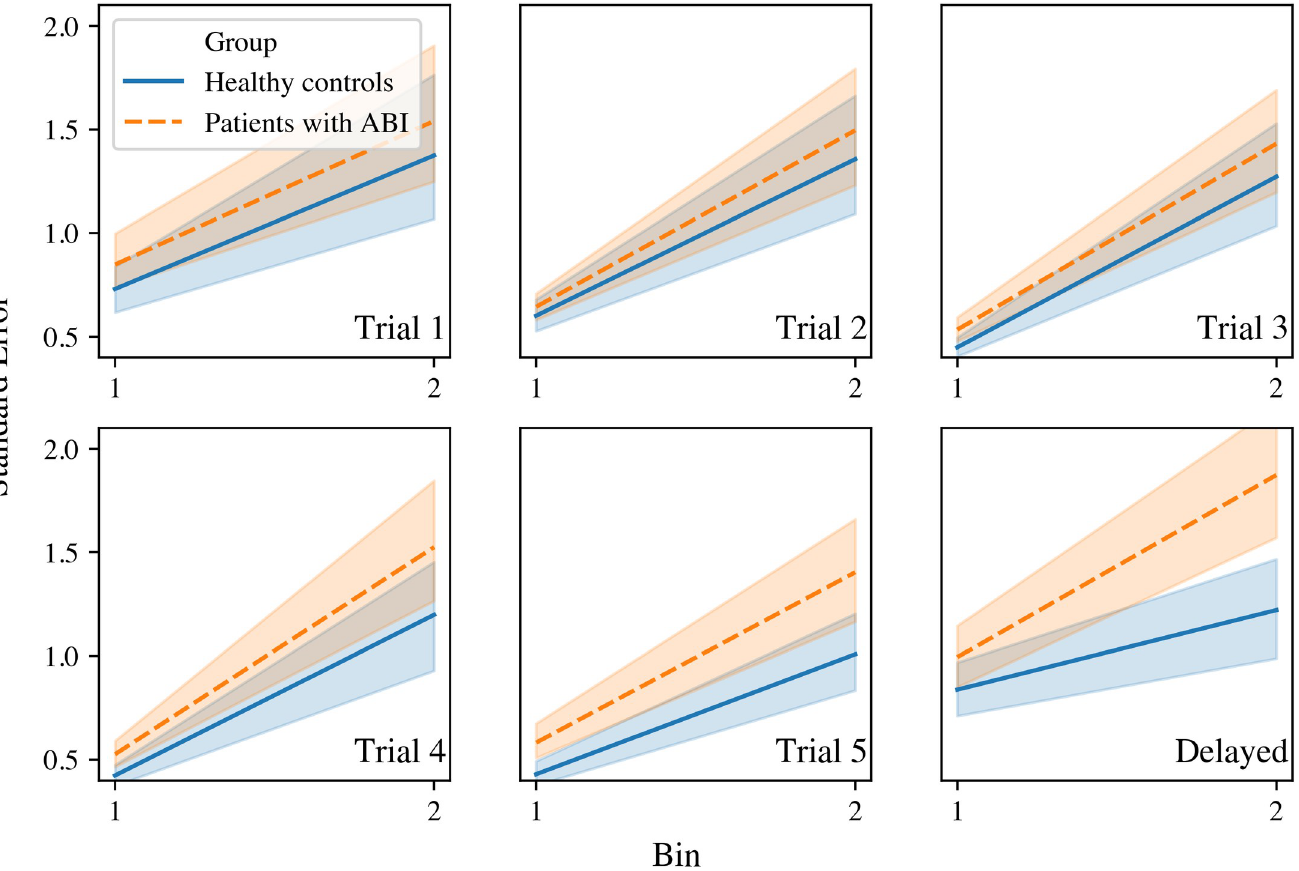
Fig 2. Performance stability in naming speed (with time between responses as outcome measure) on the RAVLT immediate recall (trial 1, 2, 3, 4 and 5) and delayed recall at group level. Each trial was divided into 2 bins (horizontal axis). The standard error (as measure of variability) is depicted on the vertical axis. Patients fluctuated significantly more in naming speed compared to healthy